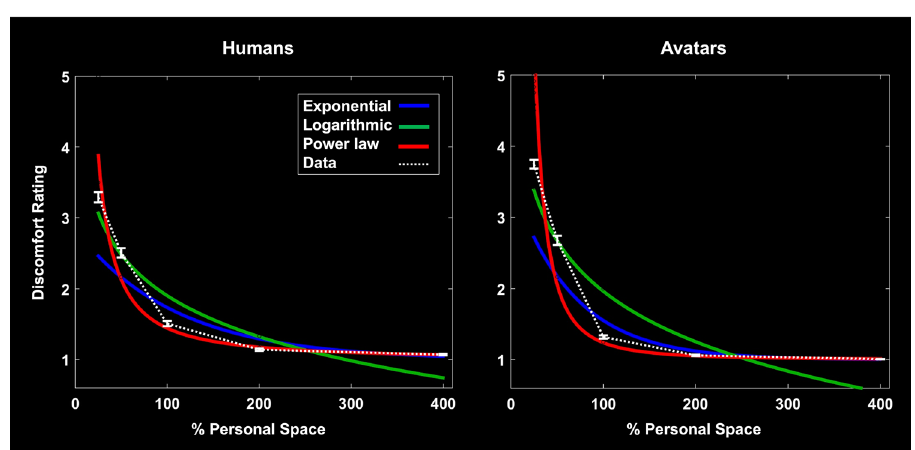
Figure 6. Model fitting of discomfort ratings data. Average ratings of discomfort (y axis) as a function of personal space size (in %, on the x axis) to either human (left panel) or avatar (right panel) intruders. In both panels, the data is shown as a white dotted line. Brackets indicate one standard error. Three possible functions were tested to model the average fall-off of comfort ratings, including exponential (blue), logarithmic (green), and a power law (red). The power law function produced the best